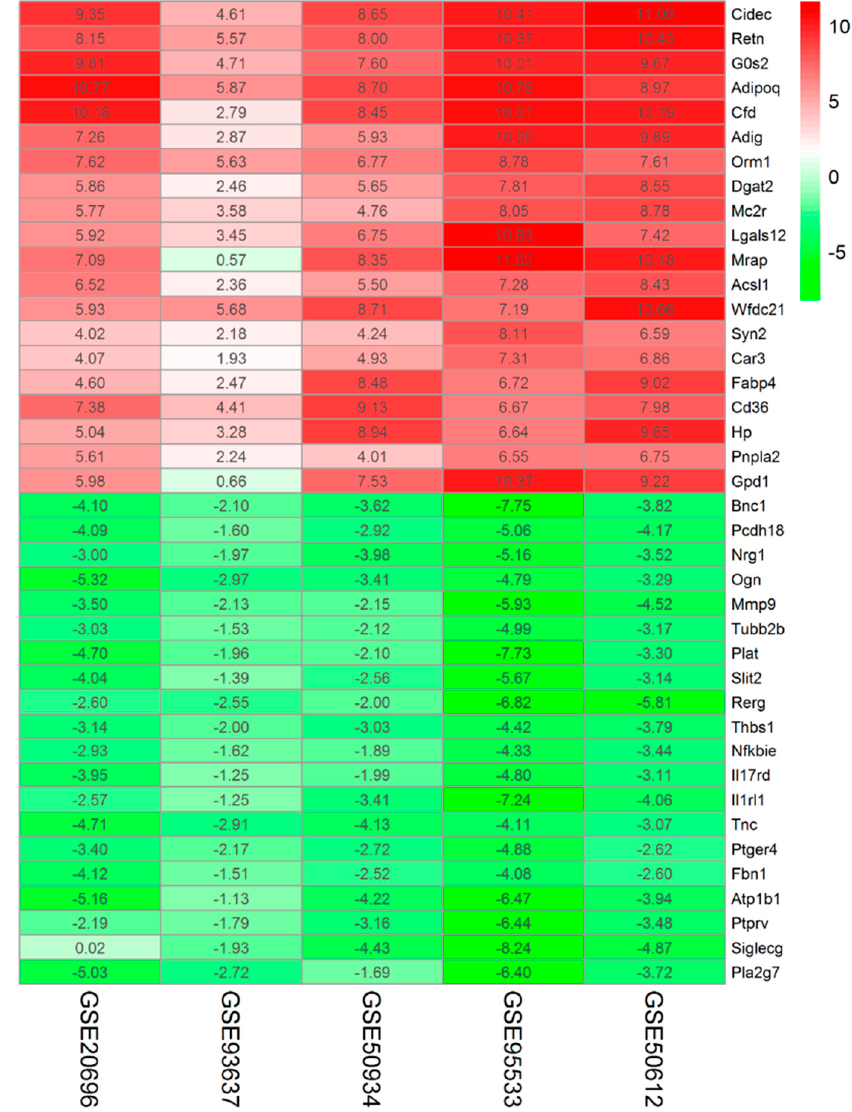
Figure 2. Heatmap of the top 20 up- and down-regulated DEGs in the integrated analysis. Each row represents one gene, and each column represents one dataset. Red indicates that the expression of genes is relatively upregulated, and green indicates that the expression of genes is relatively downregulated. The number in each rectangle represents the value of log 2 FC.